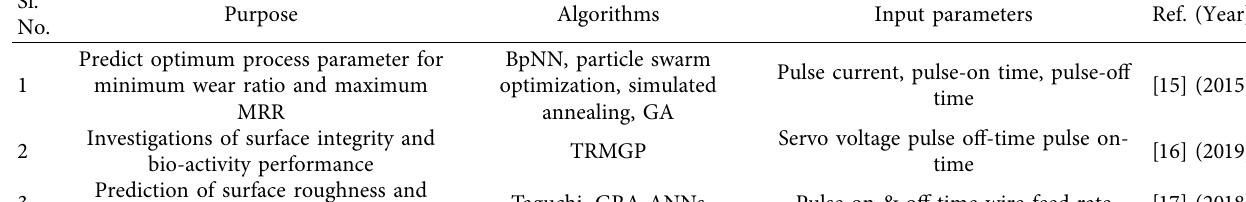
Table 2: Cases of nontraditional machining processes using machine learning algorithms. Sl.